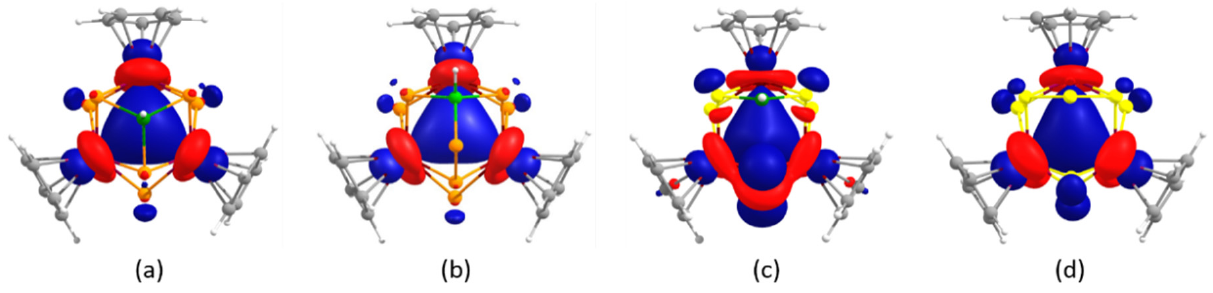
Figure 3. ( a ) HOMO of 1 , ( b ) HOMO of 2 , ( c ) HOMO of 3, and ( d ) HOMO of 4 depicting bonding within triangular Nb 3 frameworks. (Contour values for isosurface = ±0.04 [e/bohr 3 ] 1/2 ). The triangular trimetallic skeleton of 1 – 4 further captured borate, borane, and chalco- gen units. Therefore, we further analyzed the way they bind together. An MO analysis of 1 showed significant orbital overlap interaction between the triangular Nb 3 framework and the selenaborate {Se 3 BH} − ligand, which is depicted in HOMO-3, HOMO-6, HOMO-7, and HOMO-8 (Figures 4a and S13). Further, an NBO analysis depicted the strong B-Se bonding interaction within the selenaborate {Se 3 BH} − ligand in 1 , which is further supported by WBI (0.887, 0.887, and 0.883) for B-Se interactions. With the exception of the bonding scenario along B1-Se7 and Se7-Se5, similar types of bonding interactions were observed in the MO